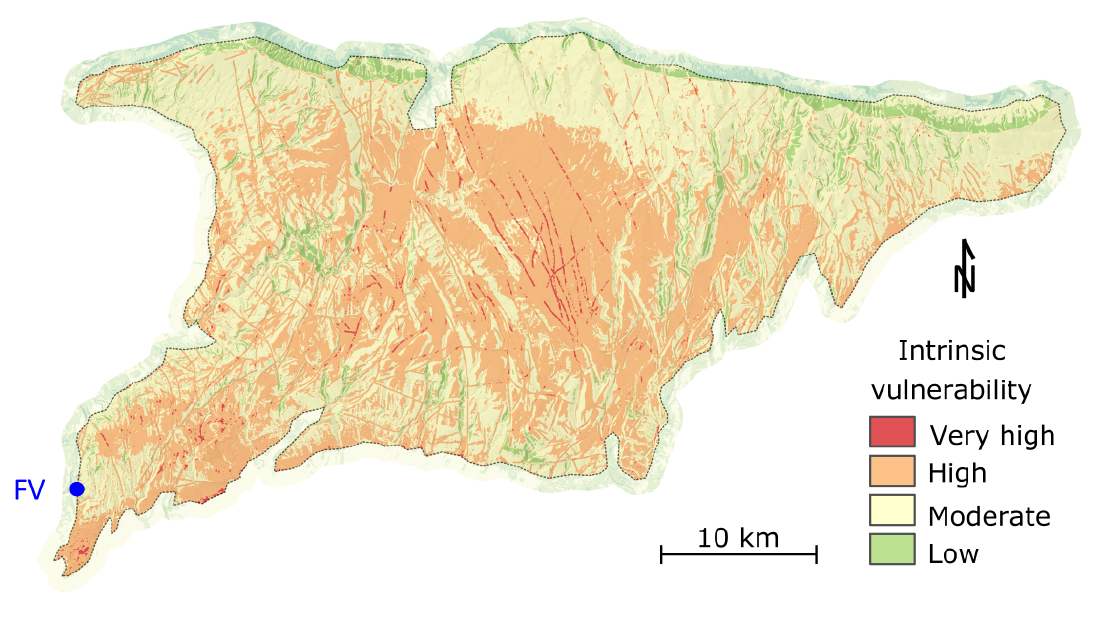
Figure 7. Fontaine de Vaucluse intrinsic vulnerability